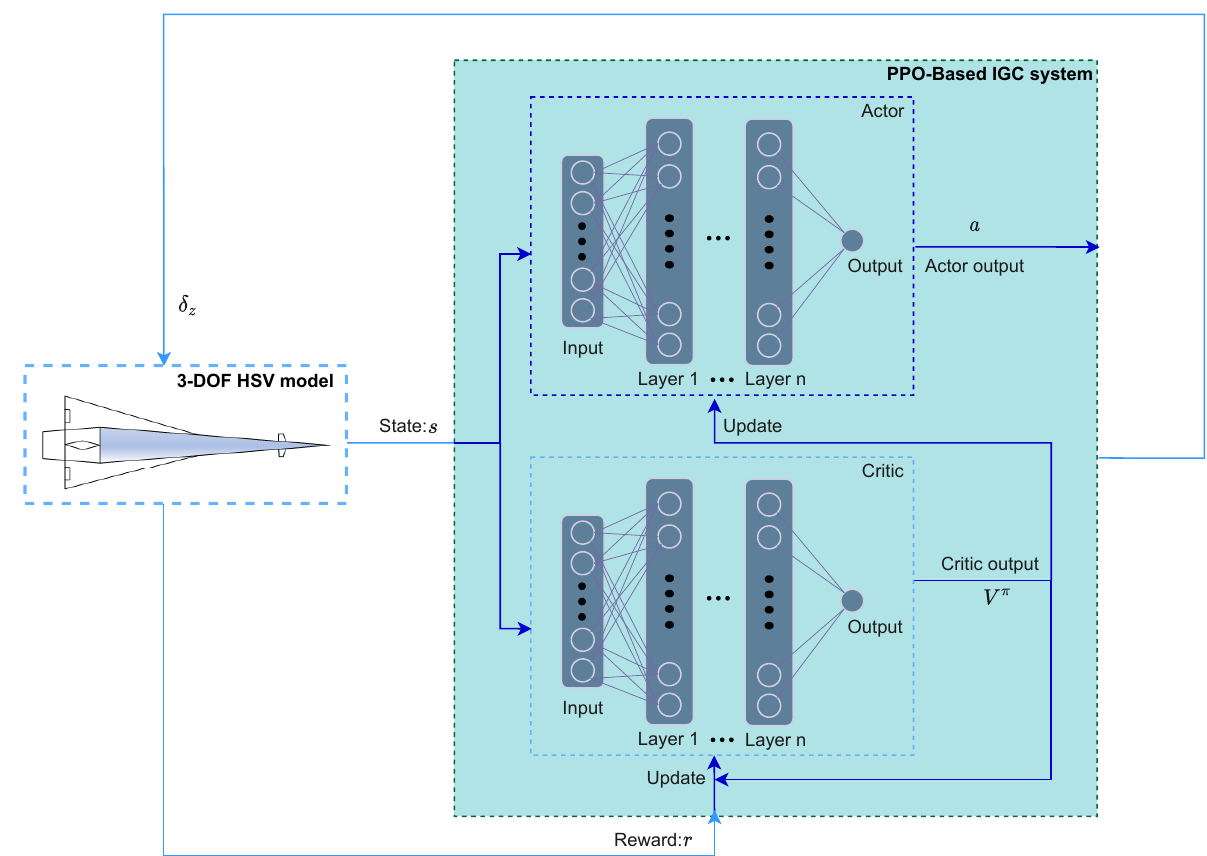
Figure 4. PPO-Based IGC